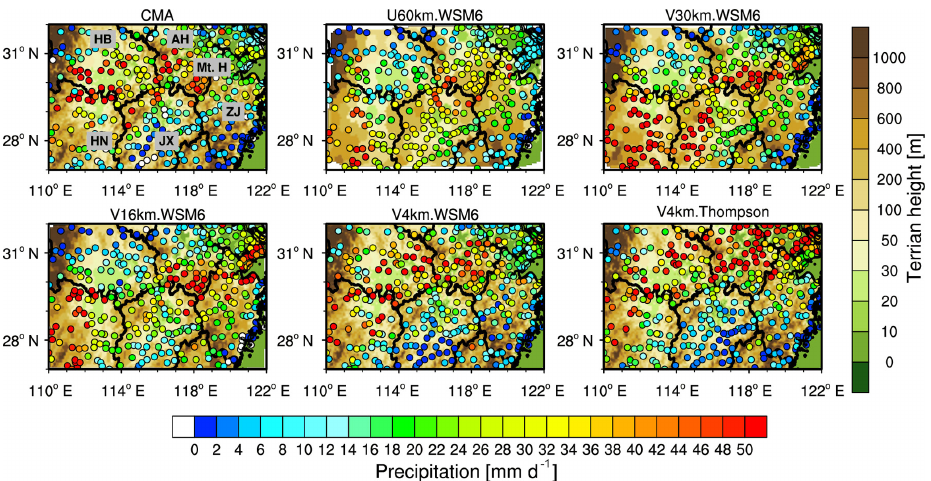
Figure 10. Spatial distributions of precipitation averaged during the event over the heavy precipitation region (27–32 ◦ N and 110–122 ◦ E) from the CMA observations and the MPAS simulations at resolutions of 60, 30, 16, and 4km. The simulations are sampled at the CMA stations. The topography is also shown. In the panel with CMA results, AH, ZJ, HB, HN, JX, and Mt. H denote the provinces of Anhui, Zhejiang, Hubei, Hunan, and Jiangxi and the Huang Mountains,